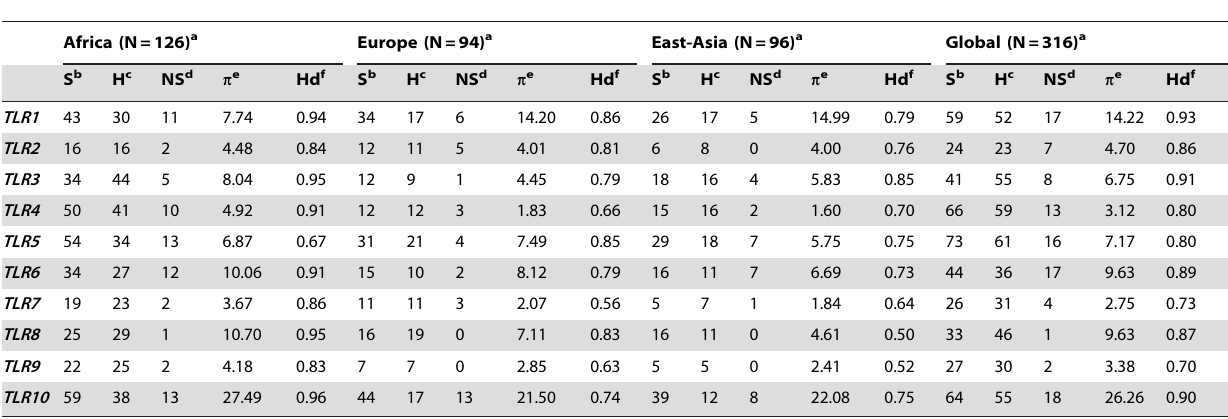
Table 1. General diversity indexes for the 10 human TLR members sequenced in the panel of healthy individuals originating from different geographic areas